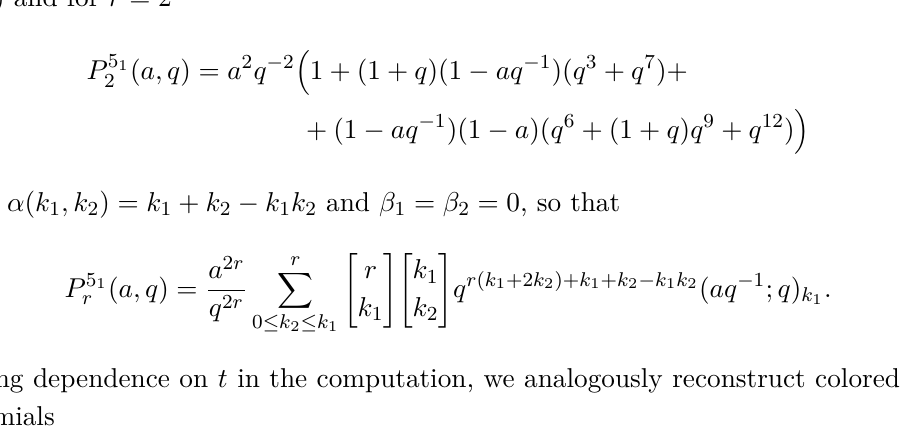
table 2) and for r =